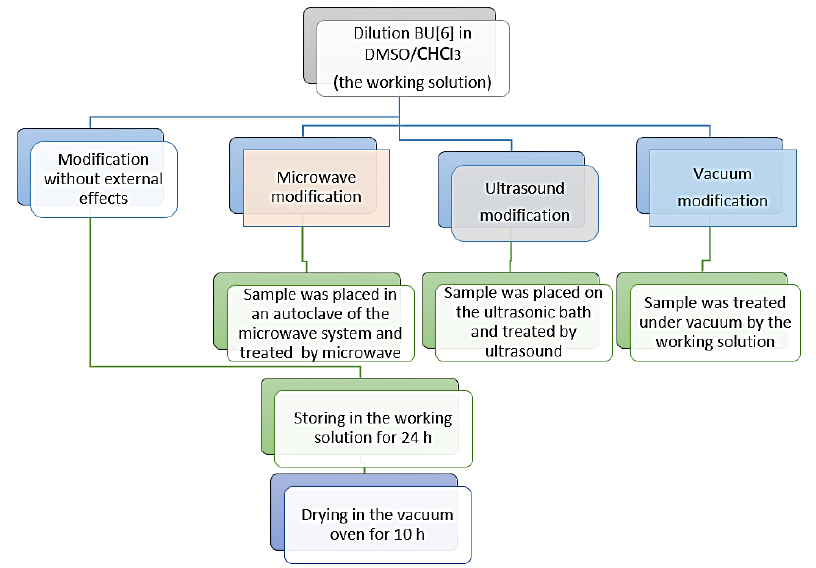
Figure 1. Flow chart of BU[6] deposition on porous TiNi samples.